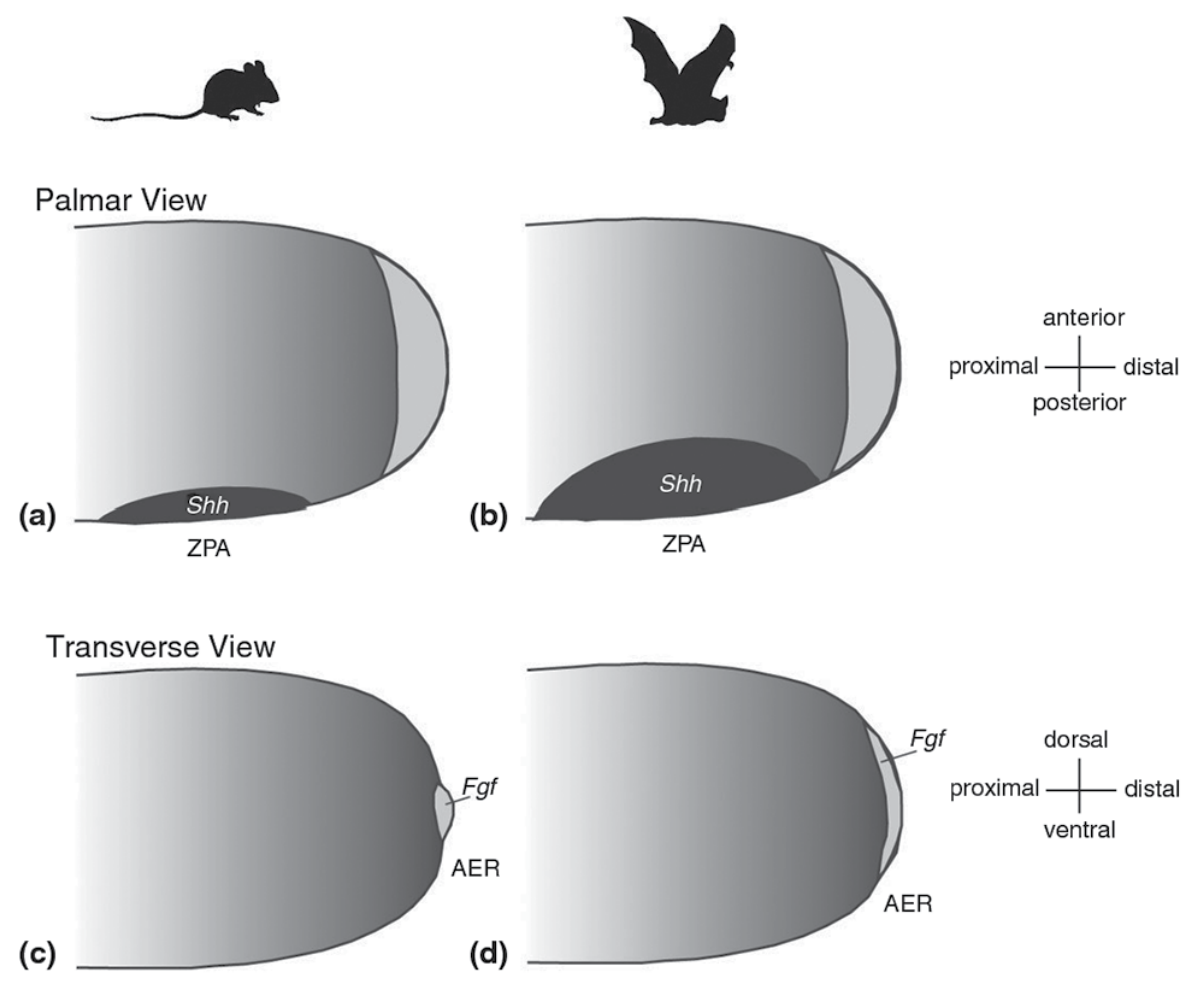
Figure 2 – Differences in signaling centers between bat and mouse limb development. Larger expression domains in bat AER and ZPA, combined with a feedback loop caused by later re-initiation of Fgf8 and Shh , contributes to lengthening in bat forelimbs (reproduced from Cooper and Sears,